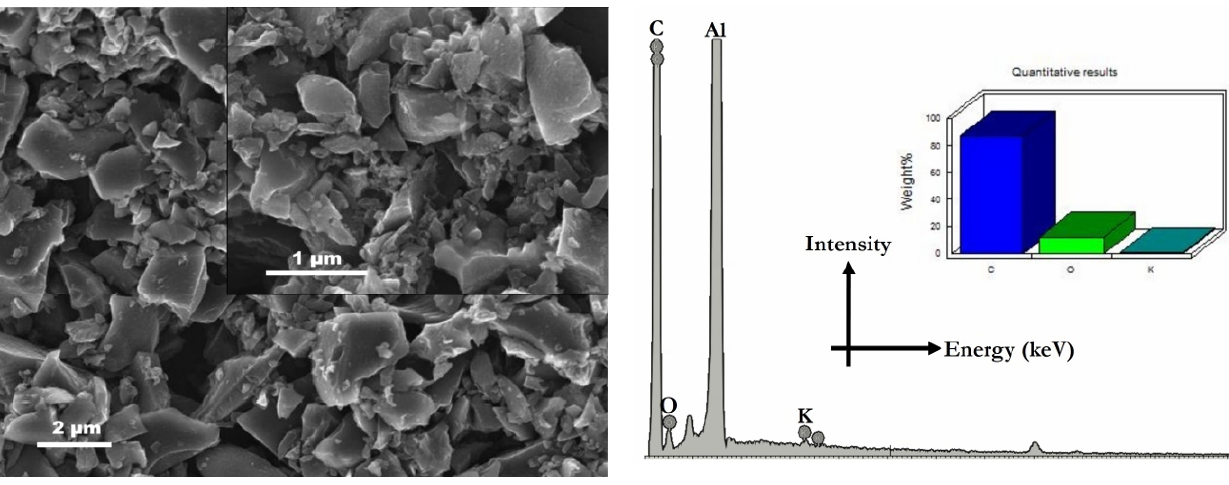
Figure 2: FESEM micrographs of pyrolyzed coconut shells particles.